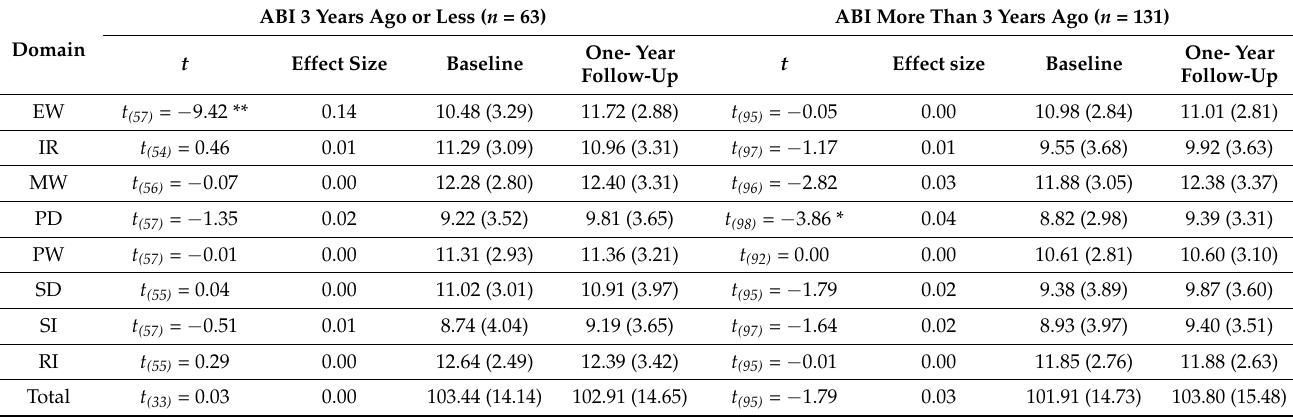
Table 3. Results by groups of time since the injury of repeated measured t -test between baseline and one-year follow-up in QoL’s domains and total